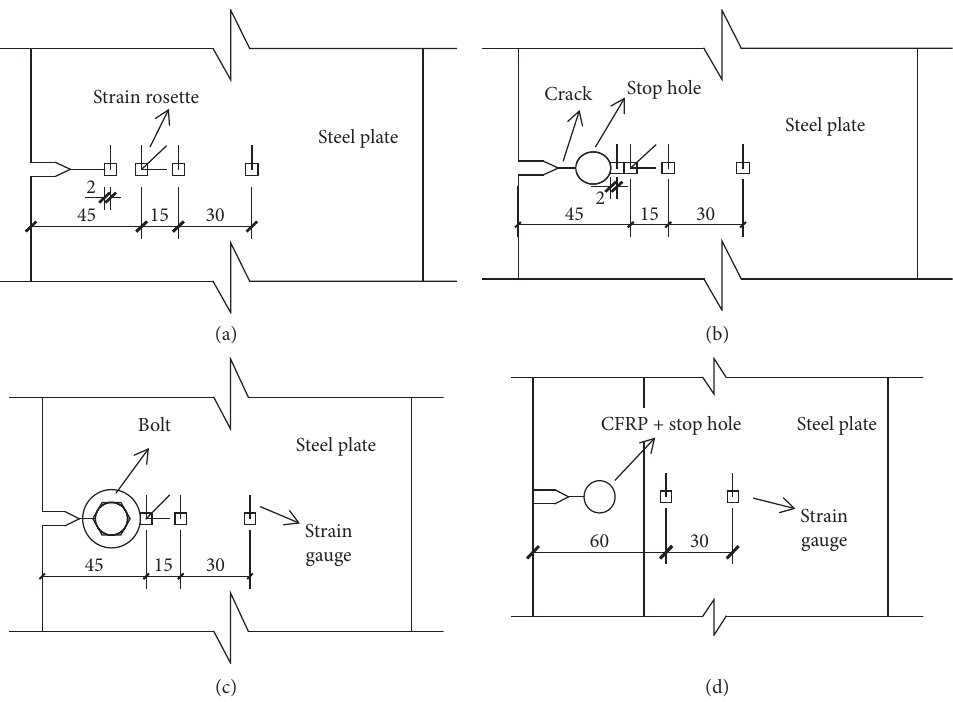
Figure 16: Locations of strain gauges on specimens for crack detection (mm). (a) Unstrengthened group. (b) Stop-hole repair group. (c) High-strength bolt stop-hole group. (d) High-modulus CFRP repair